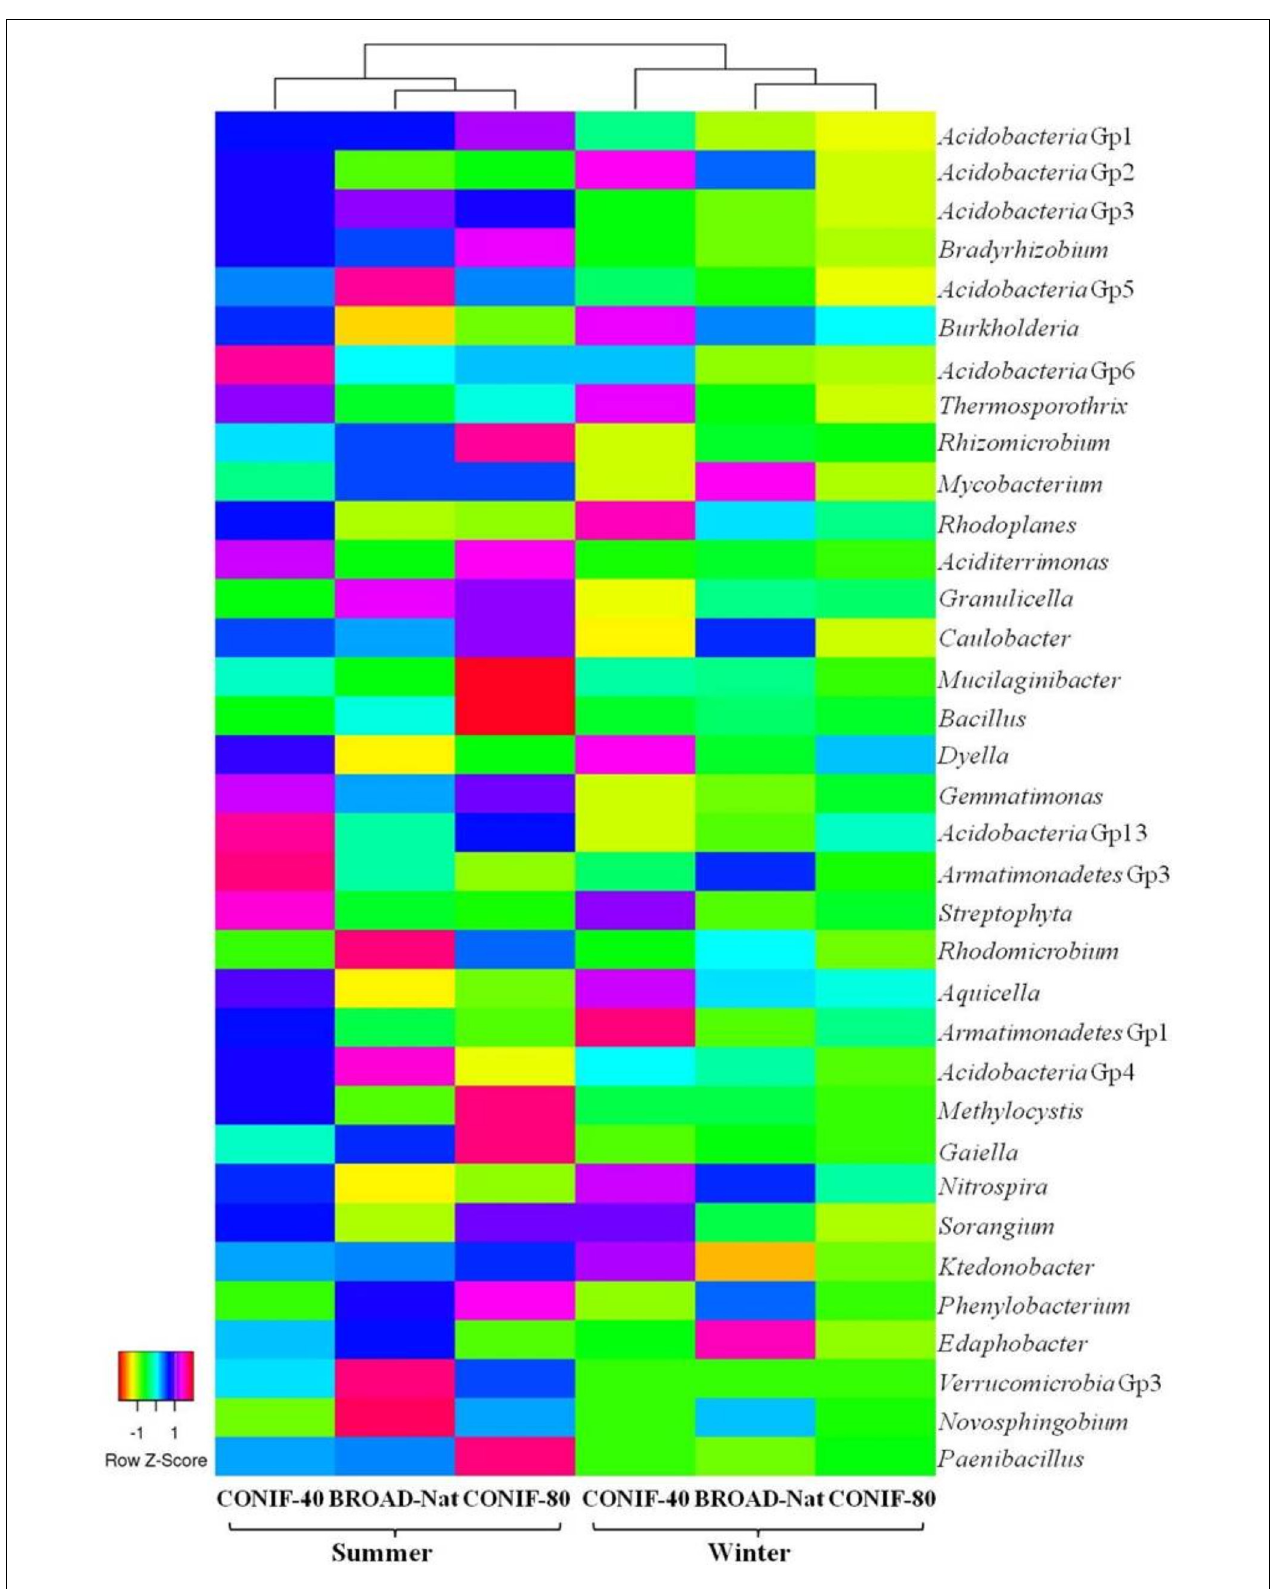
FIGURE 1 | Heat map of the 35 most abundant genera or genus-level groups of three forest soil communities. Dendrogram of the Euclidean distances between the bacterial communities is shown at the top.